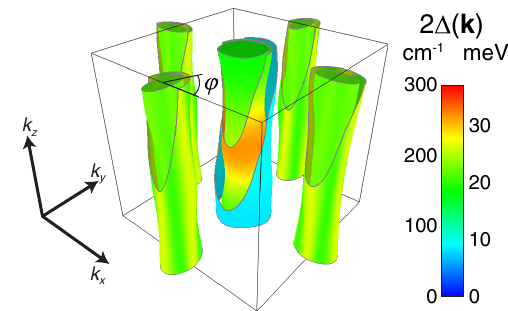
FIG. 4. Magnitudes (shown in false color) of the band- ð k Þ at the Fermi momentum k dependent gaps 2 Δ F . A moderate n gap anisotropy is found on the middle hole band h 2 with the ¼ 0 . The gaps on the electron bands absolute gap maximum at k z vary with the azimuthal angle φ and have maxima along the k x and k axes. The gap anisotropies on the inner ( h 1 ) and outer ( h 3 ) y hole bands and on the inner electron band ( e 2 ) are